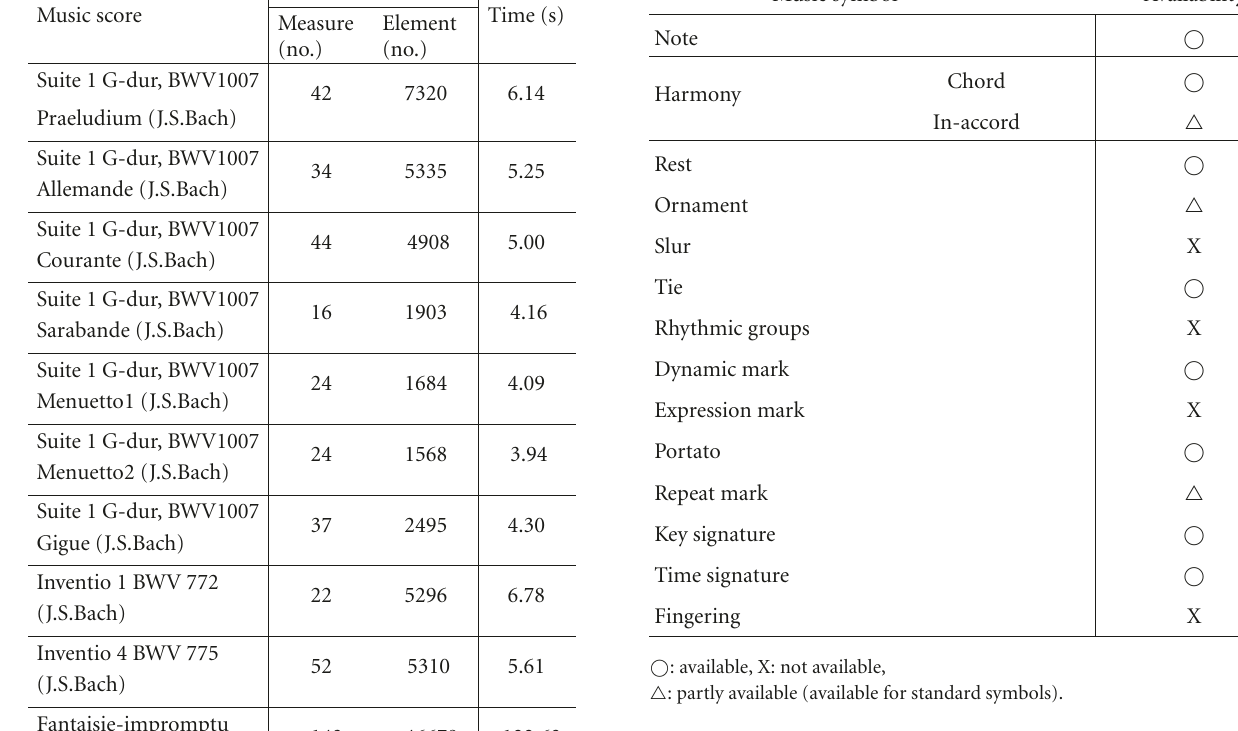
Music symbol Availability